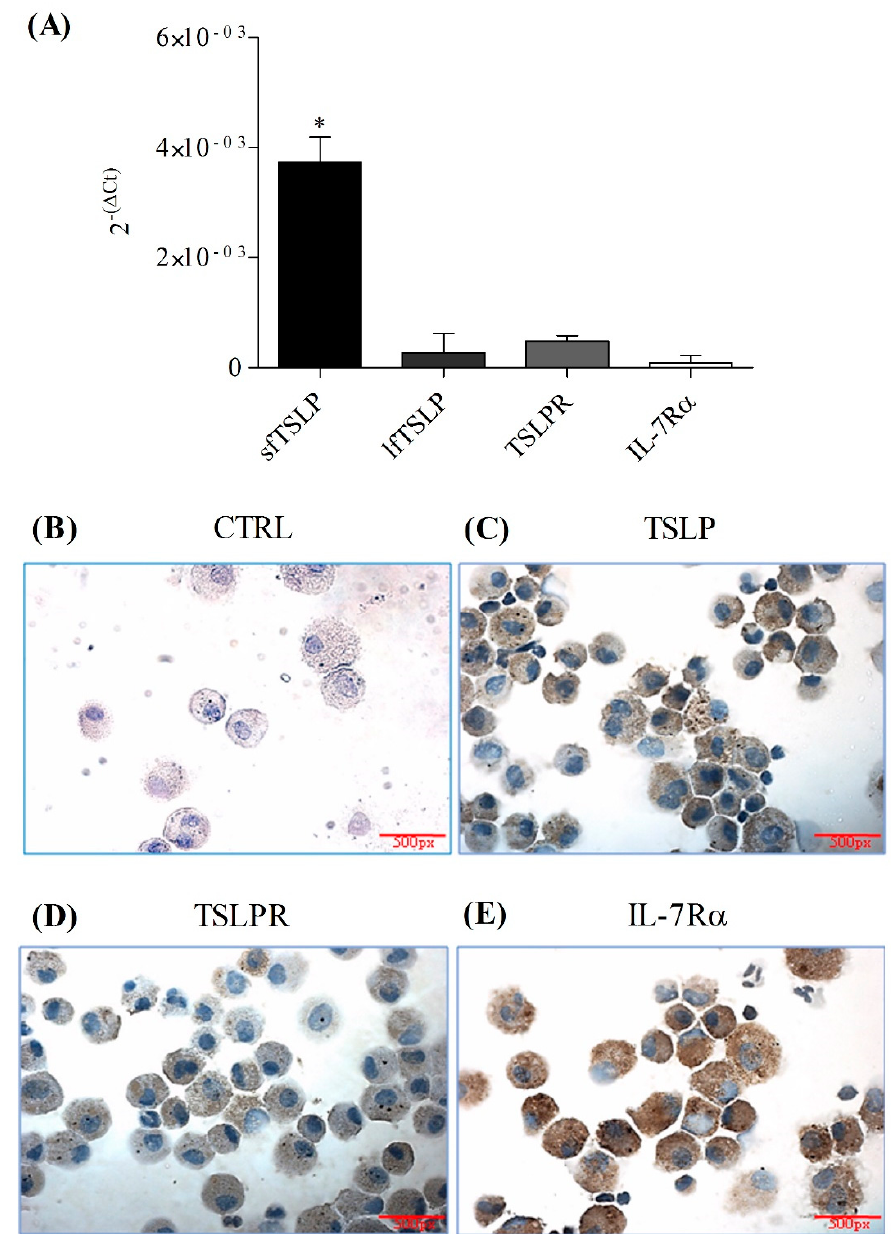
Figure 1. Constitutive expression of TSLP system in human lung macrophages (HLMs). The constitutive expression of sfTSLP, lfTSLP, TSLPR and IL-7R α mRNAs was evaluated by quantitative RT-PCR in highly purified HLMs (4.5 × 10 6 cells/well) ( A ). Data are mean ± SD of 6 independent experiments obtained from different patients. Cytocentrifuge preparations of HLMs were immunohistochemically stained for TSLP ( C ), TSLPR ( D ), and IL-7R α ( E ) with specific primary antibodies or in absence ( B ) of primary antibody (CTRL) as described in Materials and Methods. Microscope magnification 60 × . Results are representative of 6 independent experiments obtained from different patients. * p < 0.01 when compared to lfTSLP, TSLPR, IL-7R α . px: pixels.